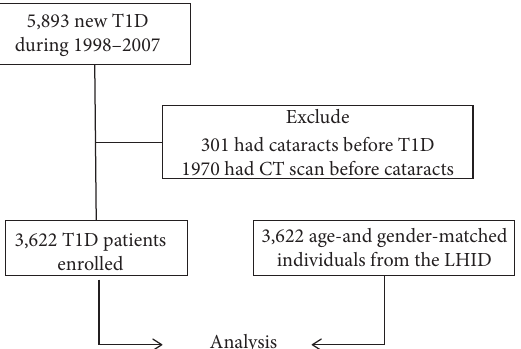
Figure 1: Study flow chart. Between 1998 and 2007, 5,893 patients were identified with new-onset type 1 diabetes (T1D) in Taiwan. After excluding 301 of those with pre-T1D cataracts and 1,970 of which computed tomography (CT) imaging studies were performed prior to being diagnosed with cataracts, a total of 3,622 cases were included. Equal numbers of age- and gender-matched individuals were selected from the Longitudinal Health Insurance Database (LHID) for analysis. Table 1: The demographic features of the type 1 diabetes (T1D) group and the matched group selected from the Longitudinal Health Insurance Database (LHID). The distribution of age and gender was similar between the two groups. T1D